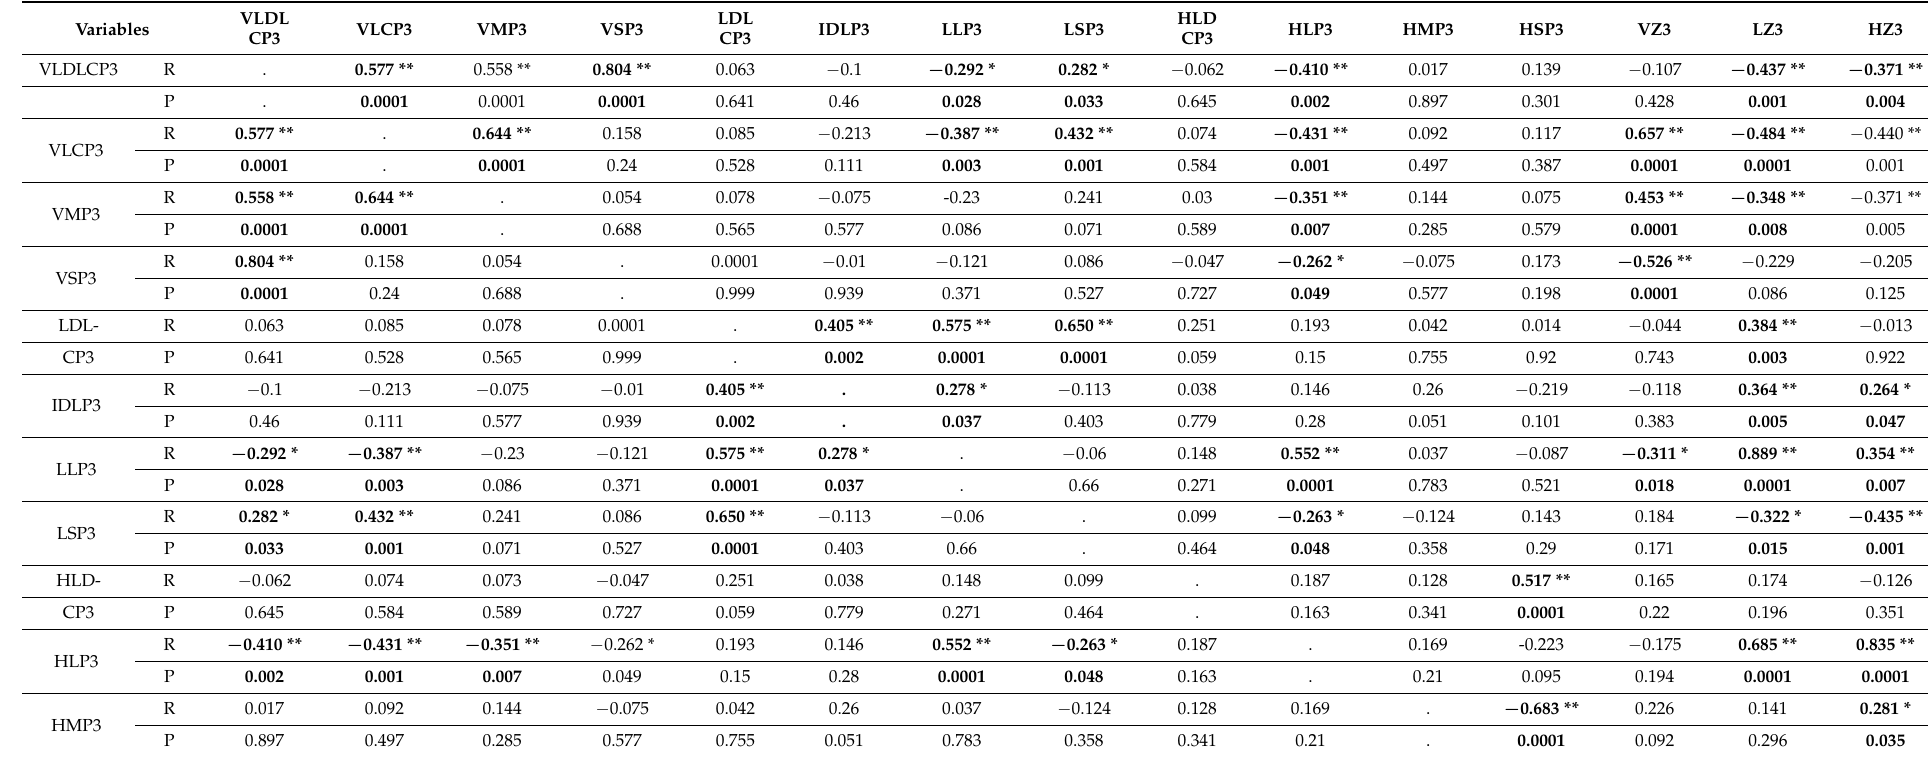
Table 3. Spearman rank correlation matrix among plasma NMR-derived lipoproteins concentration and size in T2DM